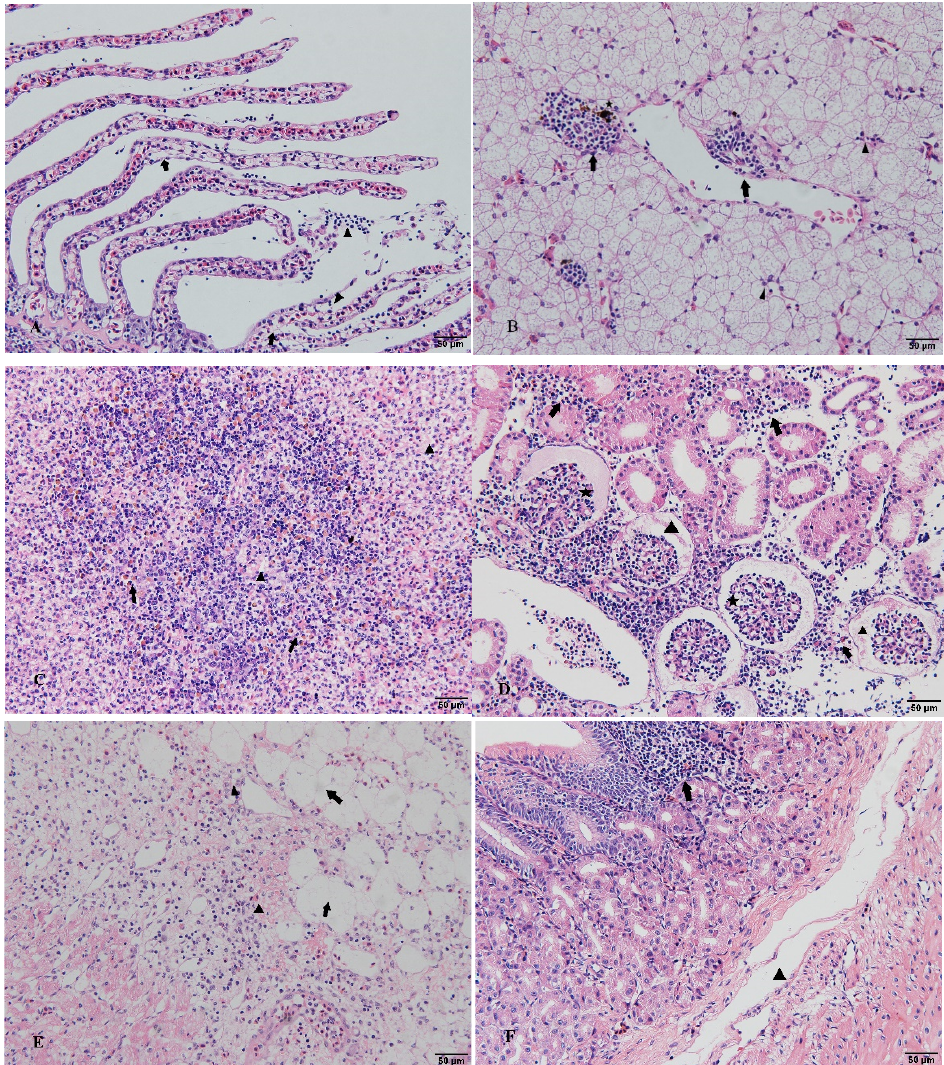
Figure 6. Histopathological observation of diseased hybrid sturgeon (scale: 50 µm): ( A ) Hyperplasia of epithelial cells in gill lamellae, hyperplastic fusion (arrow), inflammatory cell infiltration (triangle); ( B ) Hepatocyte swelling and degeneration, nuclear concentration and migration (triangle), and inflammatory cell infiltration (arrow); the presence of phagocytes in liver tissue (asterisk); ( C ) The white and red pulp structures of the spleen were blurred, cytopathic, and vacuolated (triangle) with numerous eosinophils (arrow); ( D ) Renal tubular epithelial cell necrosis, nuclear lysis, and inflammatory cell infiltration (lymphocytes, monocytes, eosinophils, etc.) of renal interstitial tissue (arrow). ( E ) Epicardial cyst, the proliferation of adipose tissue at the cyst site (arrow), nuclear deformation, dissolution, and extensive inflammatory cell infiltration (triangle). ( F ) The epidermal cells of the intestinal villi were exfoliated; the mucosal layer was infiltrated by inflammatory cells (arrow), the submucosa was loose, and the gap was enlarged (triangle).